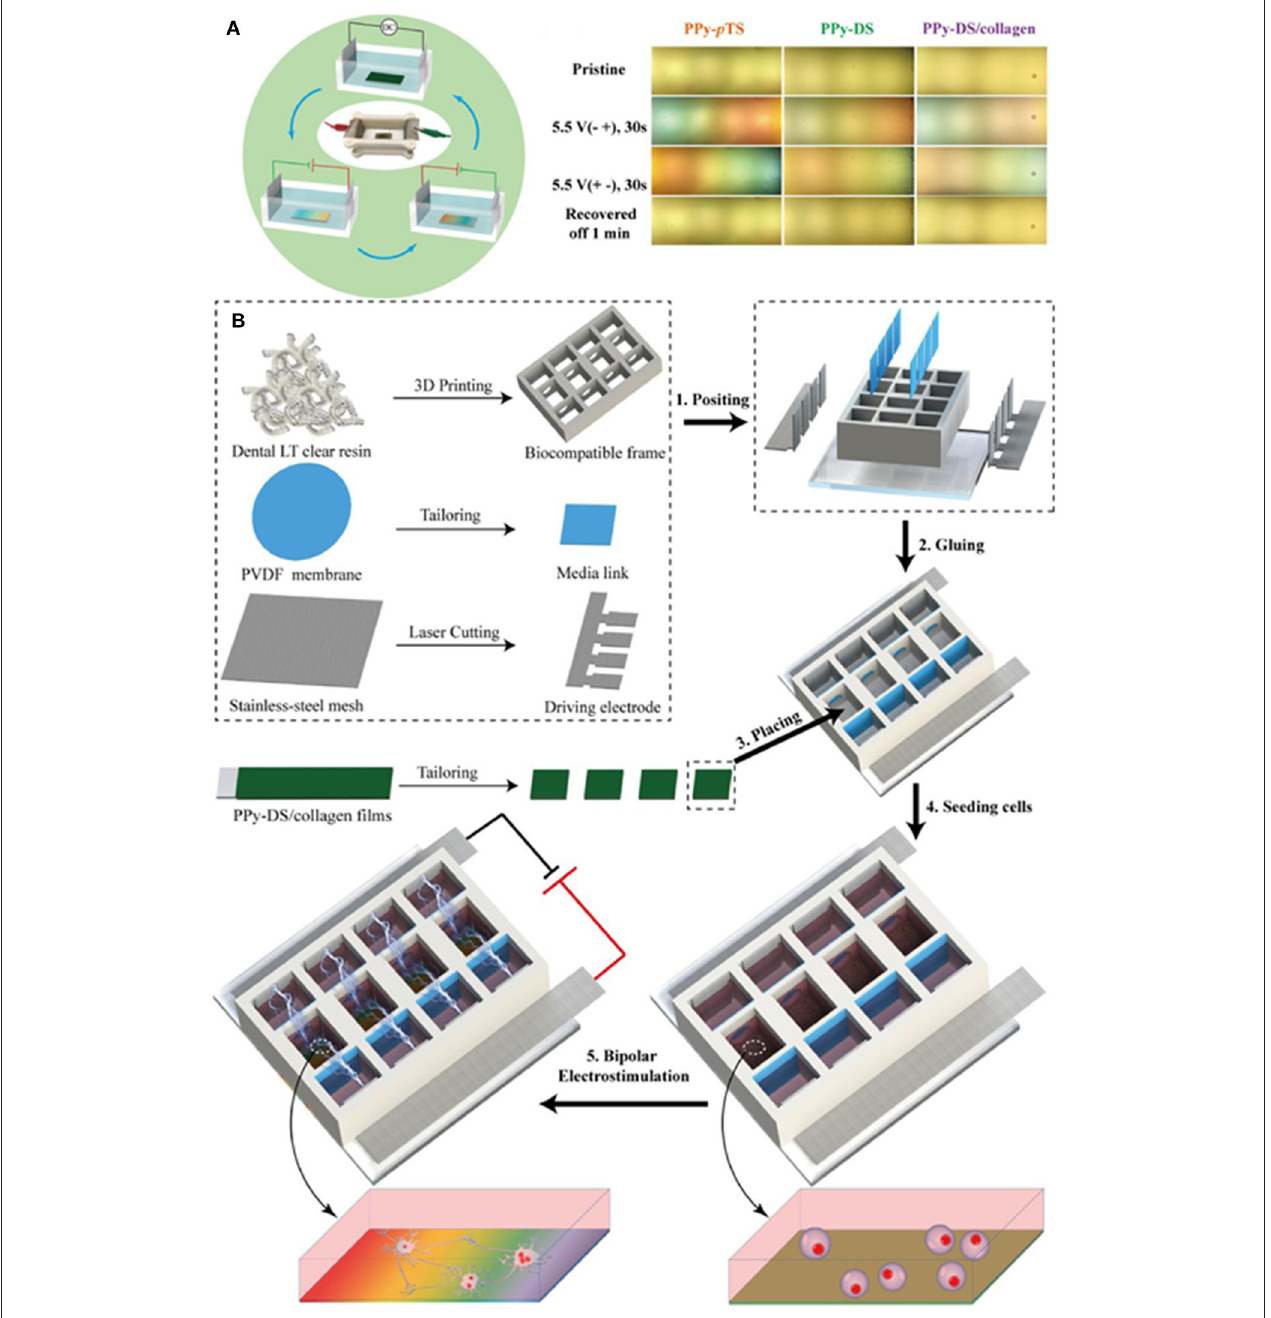
FIGURE 3 | (A) Scheme of BPES cycling and CP-immersed bipolar cells. (B) Manufacture of BPES platform. Adapted from (78) with permission from the publisher.